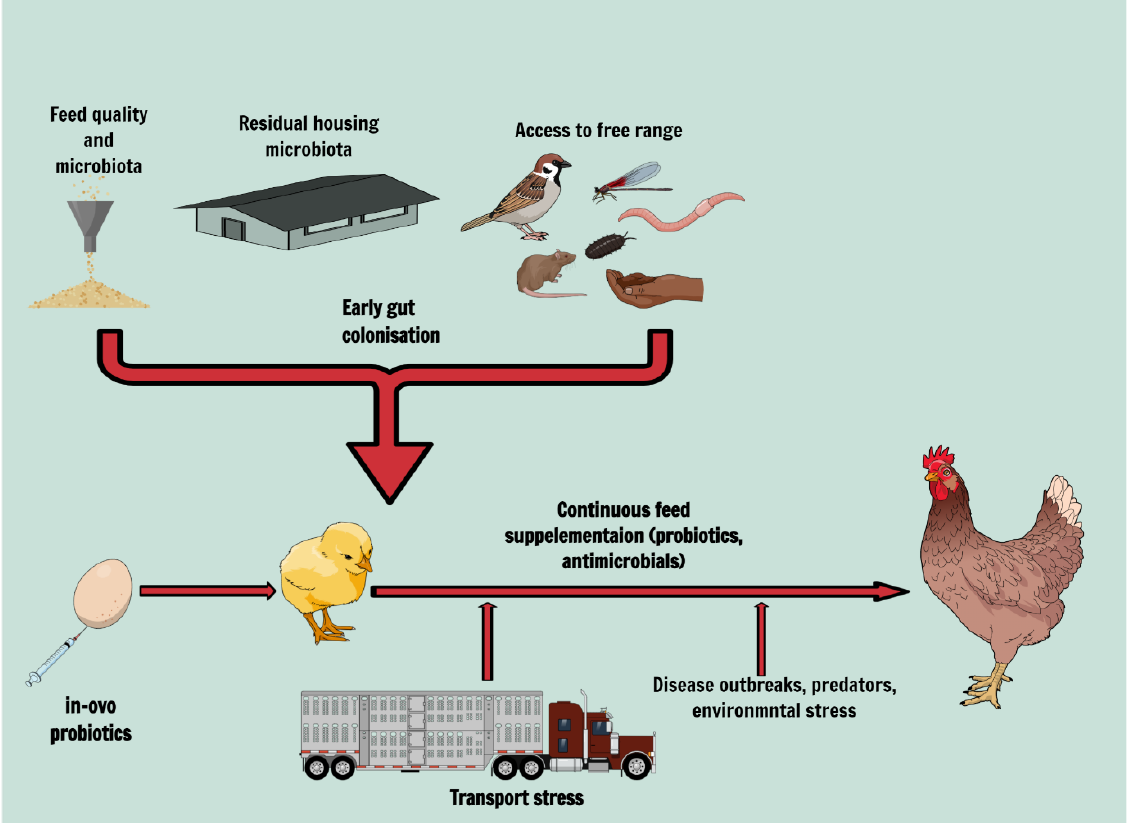
Figure 1. Range of factors influencing microbiota colonisation and maturation. Image created using Mindthegraph.